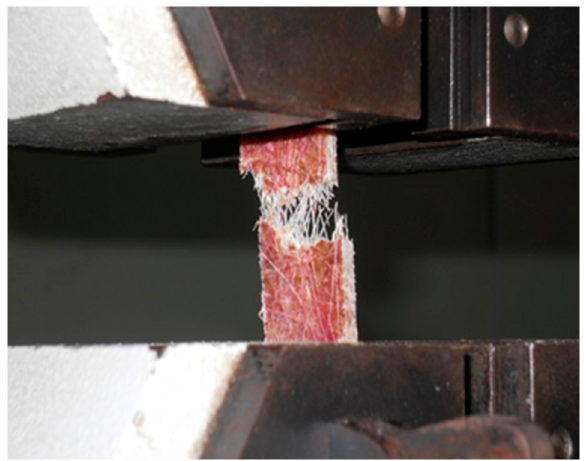
Figure 11. View of the breakage of the composite material